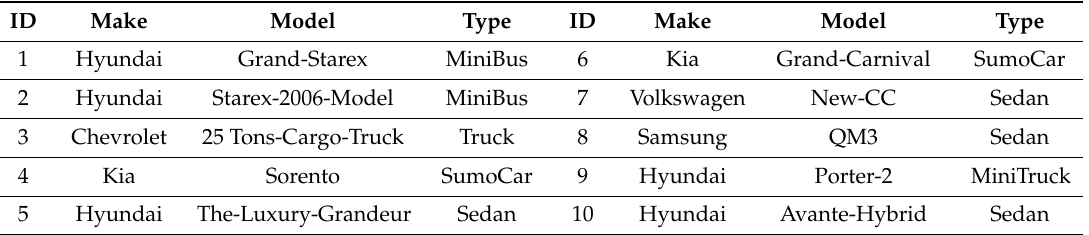
Table 1. Examples of label of make, model, and type with their respective class IDs.